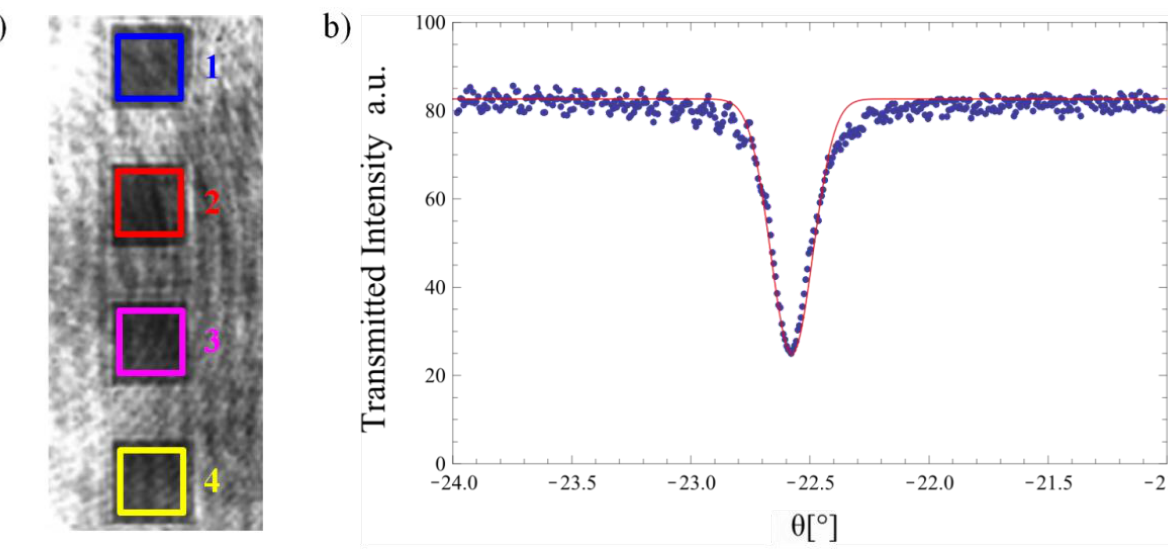
Figure 5. Experimental setup to determine the coupling angles consisting of various laser sources, rotatable mirror for source selection, filter wheel with polarizers for TE and TM polarization selection, beam expander, aperture, the mounted sample on a motorized rotation stage as well as a CCD camera for signal recording.